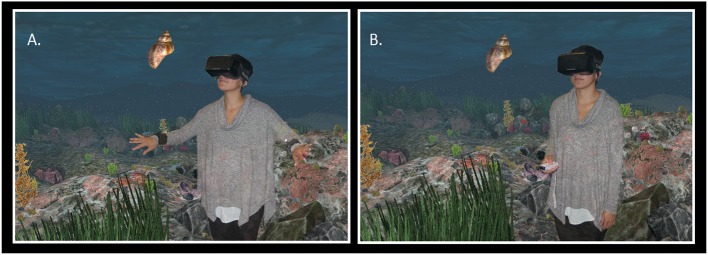
(A) The participant is shown an example of the type of species she will be looking for before she begins her species count on the virtual reef, using her arms to swim. (B) The participant is shown an example of the type of species she will be looking for before she begins her species count on the virtual reef, using the Wiimote controller to move throughout the environment.